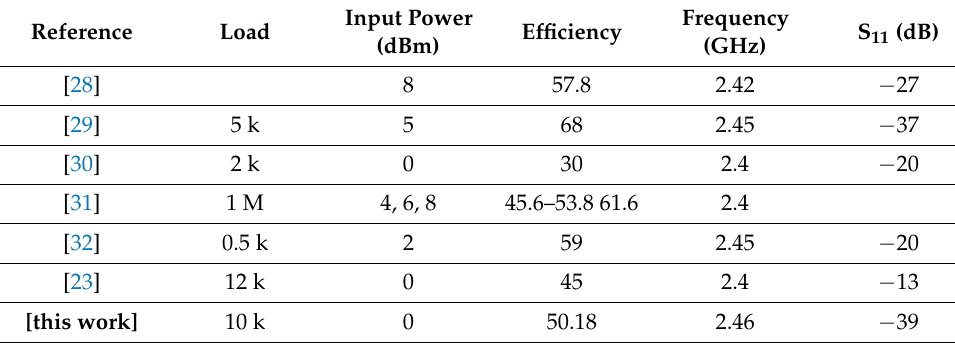
Table 7. Comparison of results vs. other similar